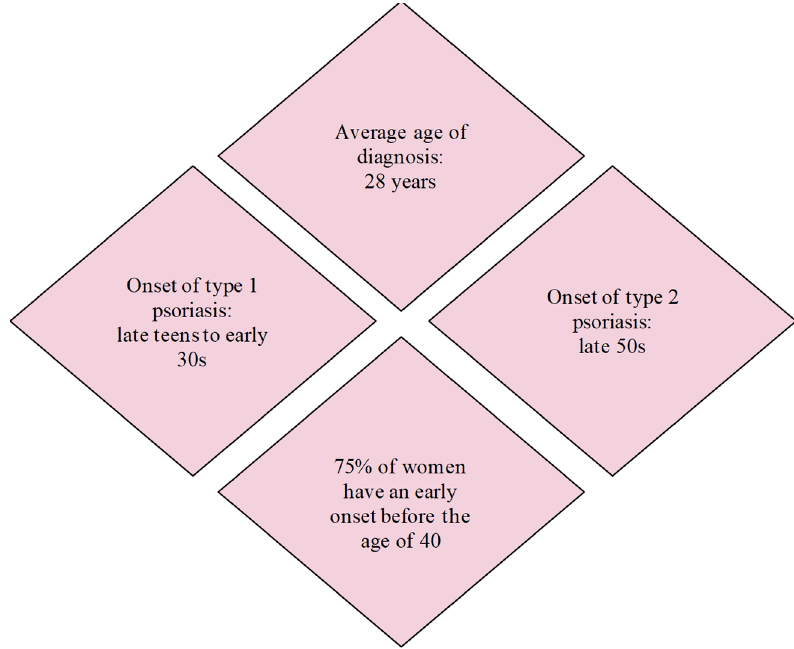
Figure 1. Women with psoriasis in childbearing age.